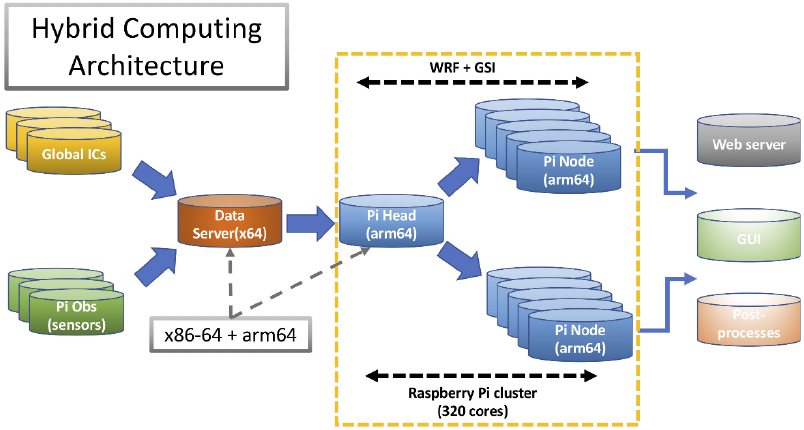
Figure 1. WRF-GSI NWP system architecture.